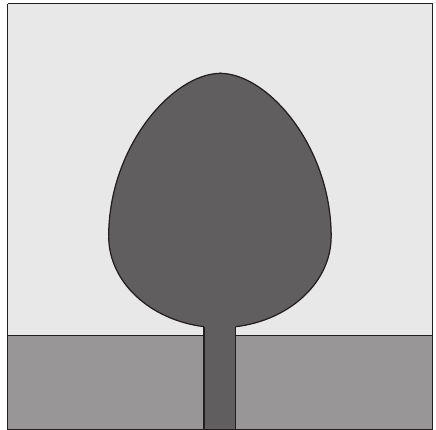
Figure 12: The printed Newton’s egg curved monopole antenna [51]. The regular contour expressed by Newton’s egg curve promotes the energy emission in the region close to the ground plane avoiding energy reflections toward the feeding line. Dark gray upper metal face, medium gray bottom metal face, and light gray dielectric